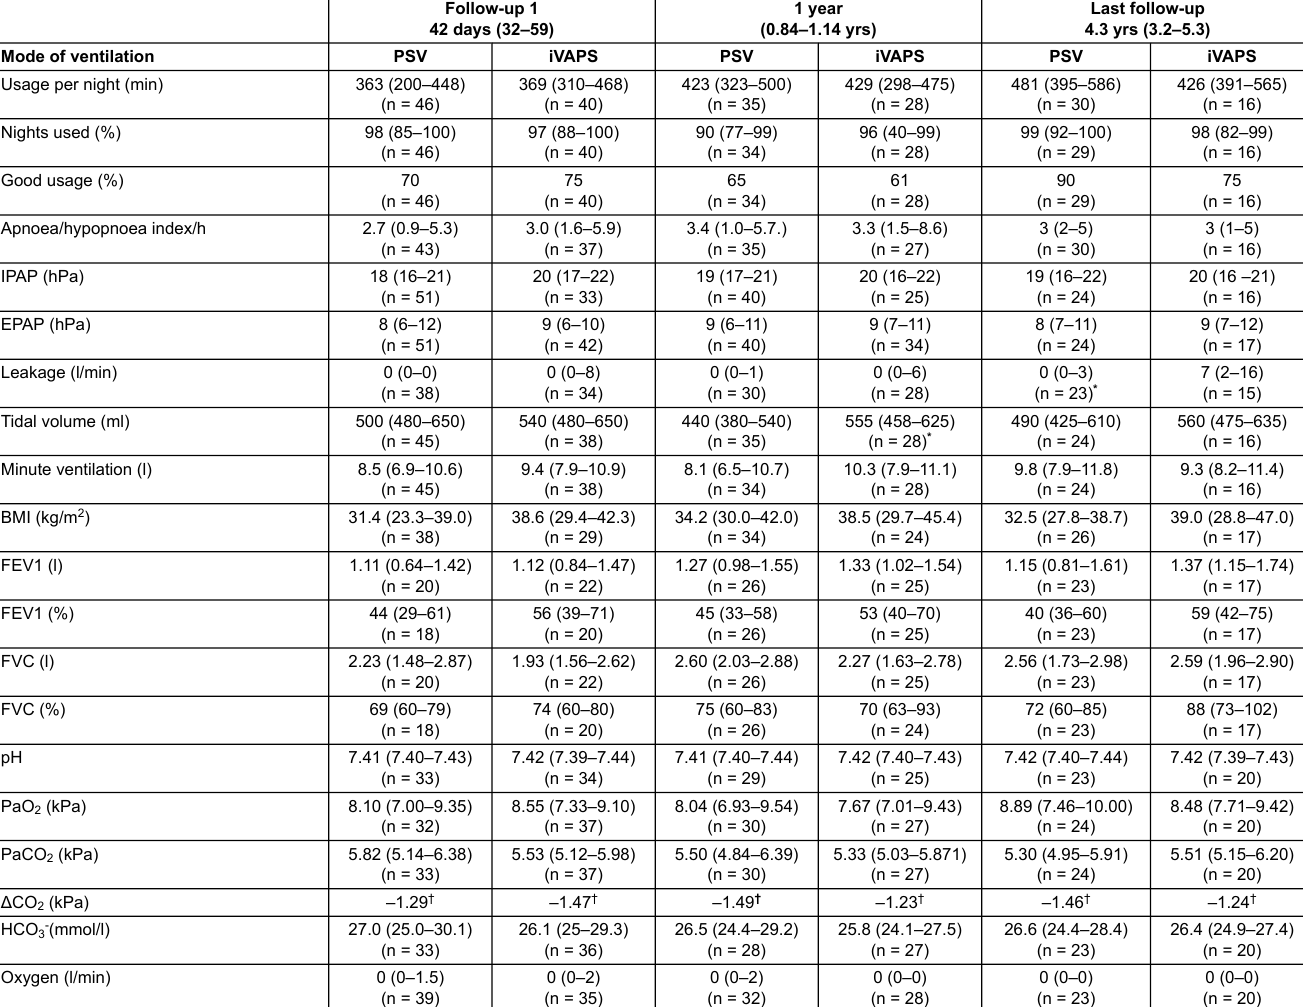
Table 2: Ventilator data, blood gas values and lung function at follow-up 1, after 1 year and at the last